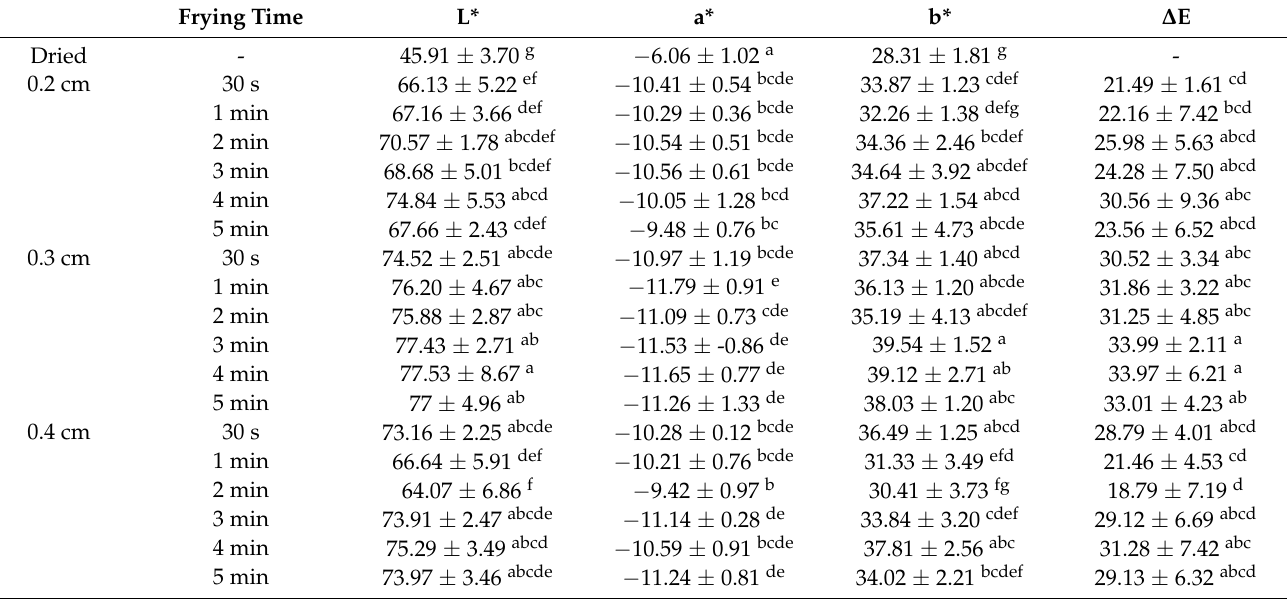
Table 4. L*a*b* value of fried pork rind with different frying time and raw pork skin